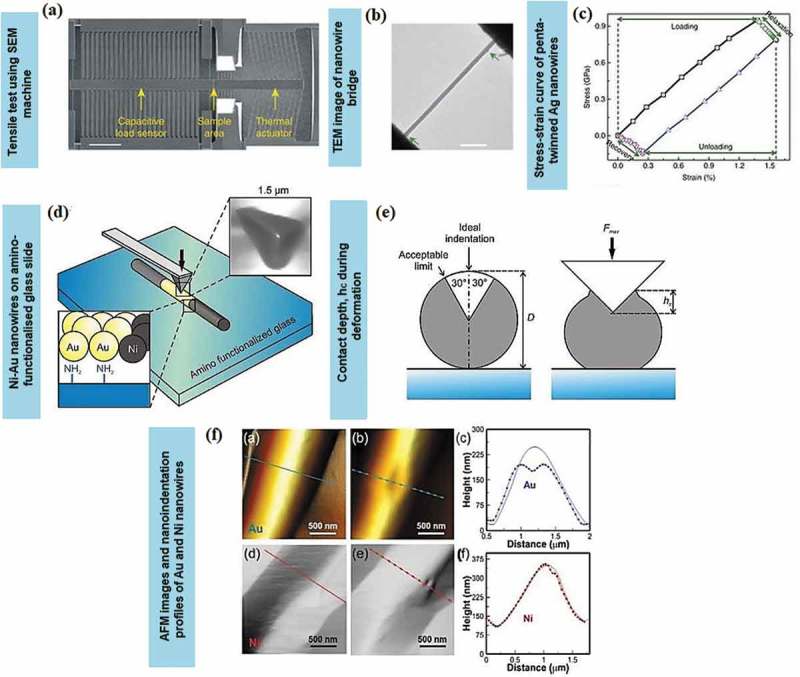
(a) The in situ tensile test of Ag nanowires using SEM with the scale bar of 200 nm [3]. (b) The low magnification of TEM image on the sample area of the nanowire bridge between the actuator and the load sensor with the scale bar of 500 nm [3]. (c) The stress-strain curves of penta-twinned Ag nanowires with a diameter of 120 nm. The relaxation and recovery states took 15 min to complete [3]. (d) Schematic of a bimetallic Ni-Au nanowire with the Au segment (yellow) attached to an amino-functionalised glass slide [236]. (e) Nanowire cross-sections indicate the acceptable indentation region (left) and the contact depth, hc during deformation (right) [236]. (f) AFM images and line profiles before and after the indentation test for both Au and Ni nanowires segments [236]. (Adapted from [3] with permission from Nature Publishing Group and reproduced from [236] with permission from Elsevier).